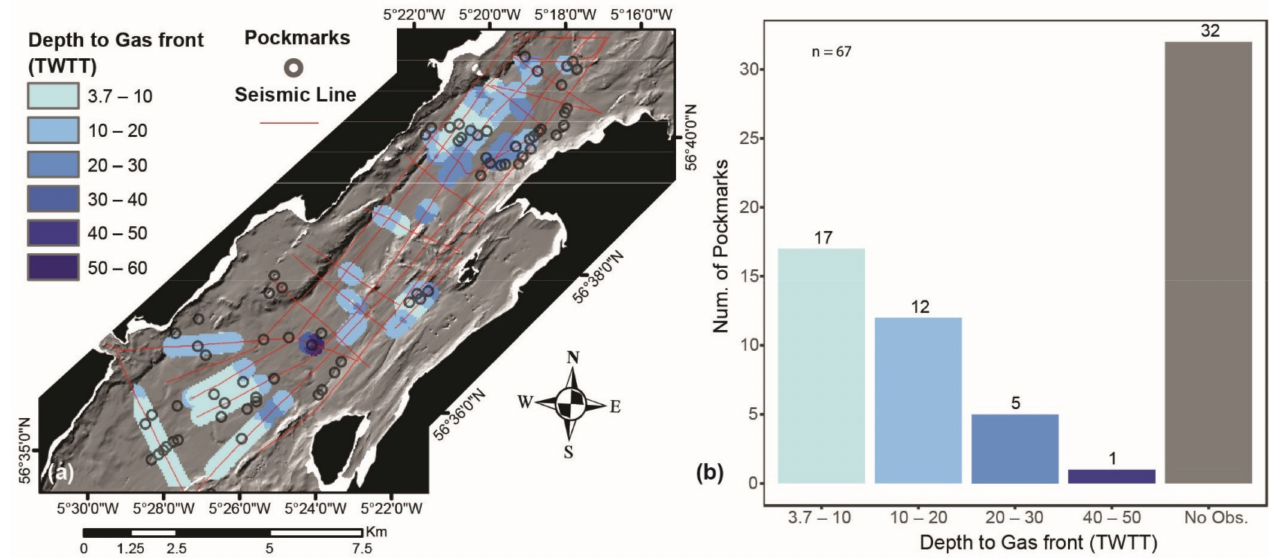
Figure 7. Study area showing boomer seismic survey lines and pockmarks; ( a ) depth to gas front (TWTT), where gas was observed in seismic profiles; ( b ) bar-plot showing number of pockmarks within each depth to gas front